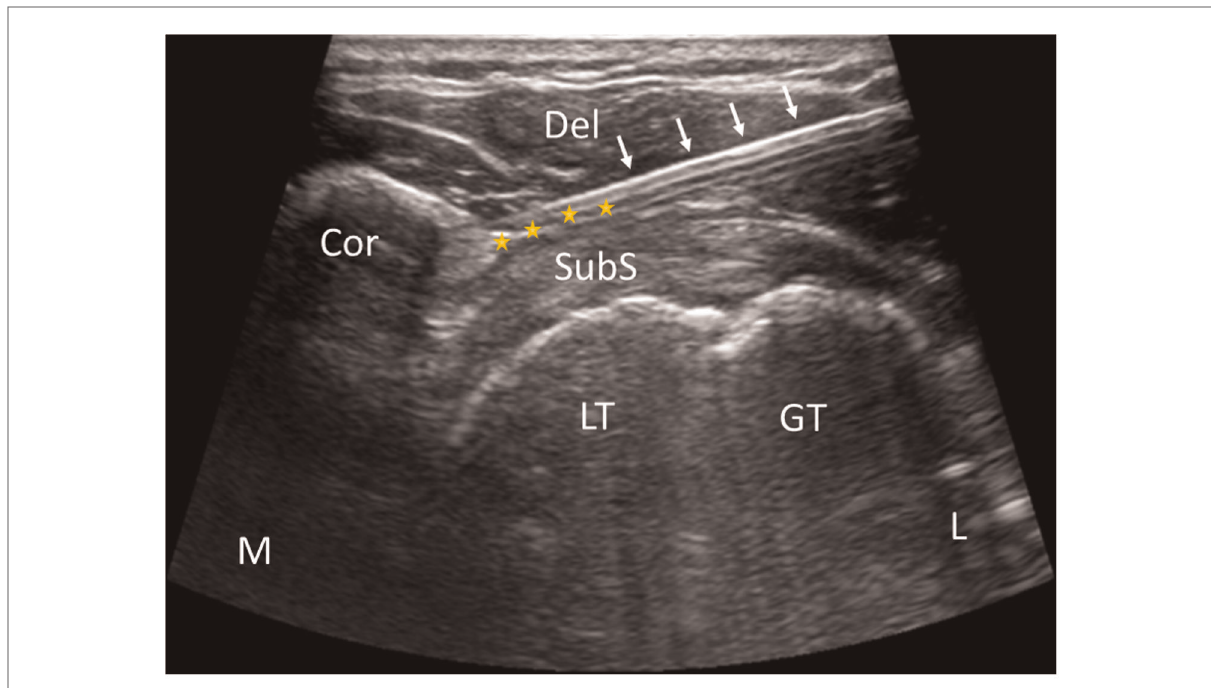
FIGURE 3 US-guided acupotome lysis of coracohumeral ligaments. Cor, coracoideus; Del, deltoid muscle; GT, greater tubercle of humerus; LT, lesser tubercle of humerus; SubS, subscapularis tendon; L, lateral; M, medial; yellow star, coracohumeral ligament. White arrows indicate the acupotome.